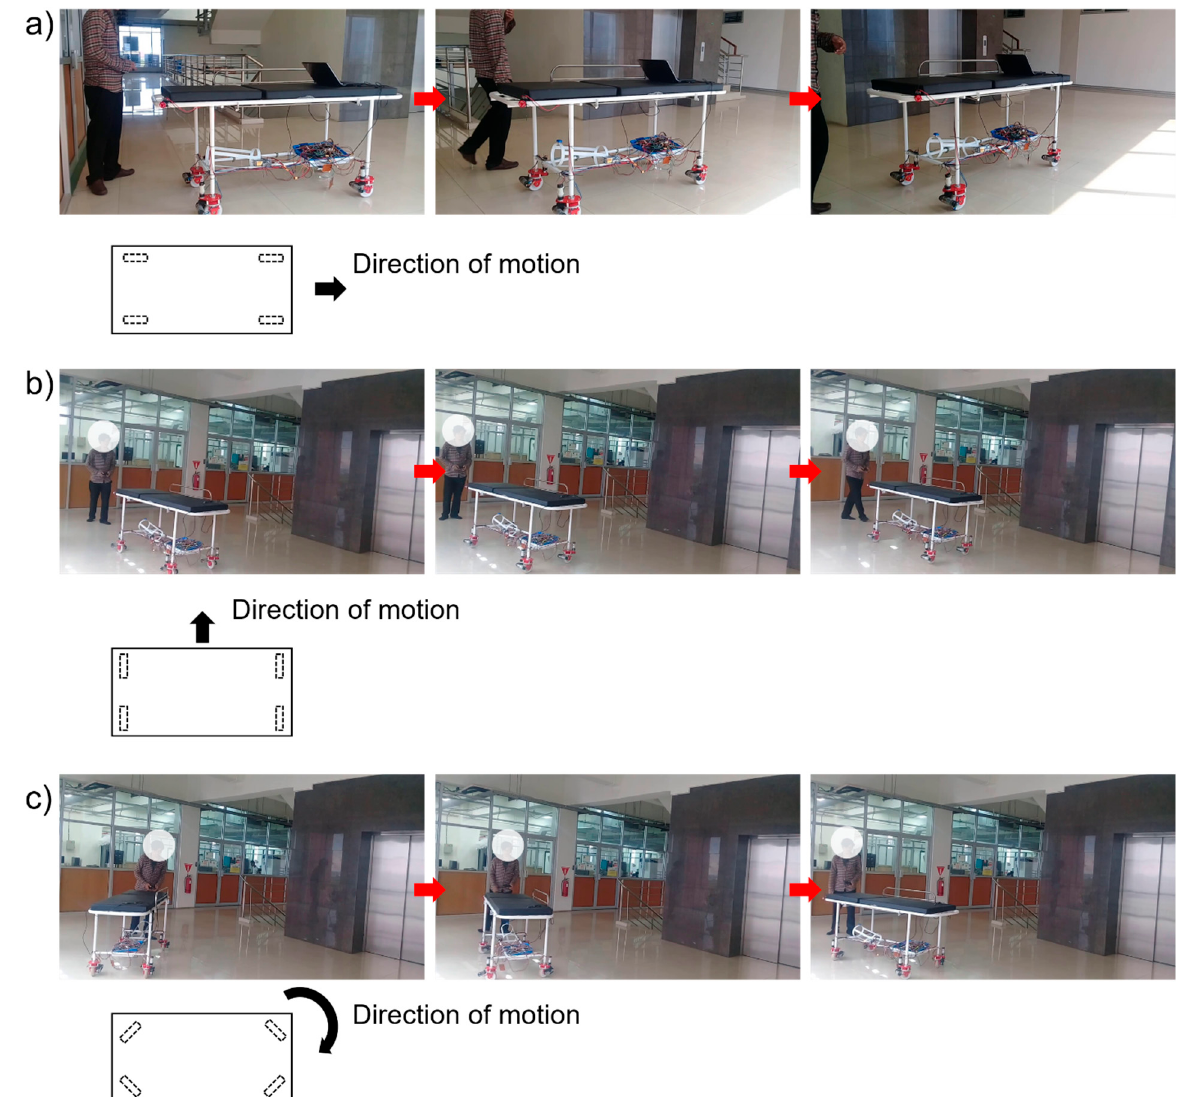
Figure 7. Snapshots of the demonstration videos for ( a ) straight-path motion, ( b ) right-angle turn, and ( c ) rotational mo- tion.